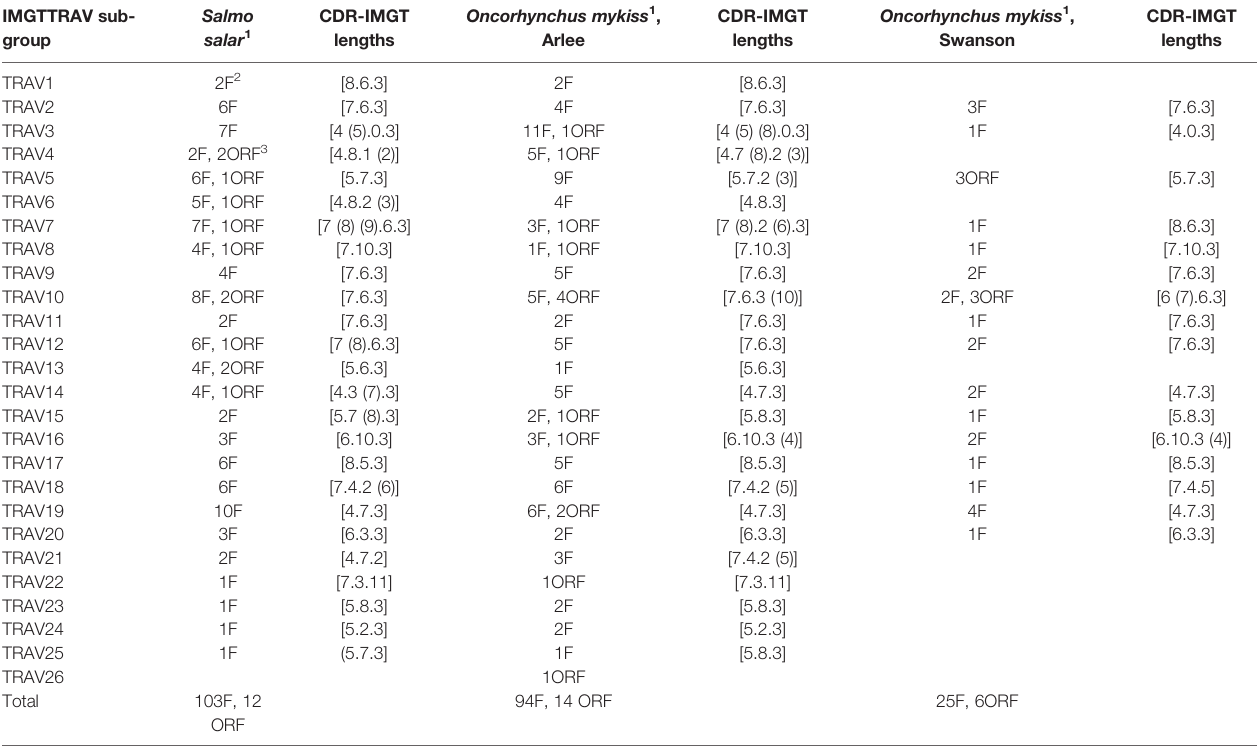
TABLE 1 | Characterization of the TRAV subgroups (number of genes per functionality F and ORF and CDR-IMGT lengths) in atlantic salmon ( Salmo salarSalmo salar) and rainbow trout (Oncorhynchus mykiss) arlee and swanson strains. Salmo CDR-IMGT IMGTTRAV sub- salar 1 group